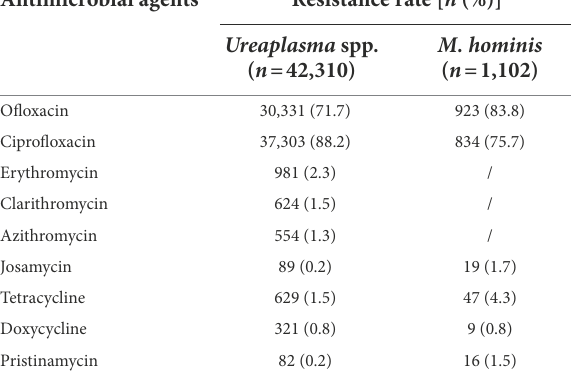
TABLE 2 Overall resistance rates of Ureaplasma spp. and M. hominis isolates from 2013 to 2019. Antimicrobial